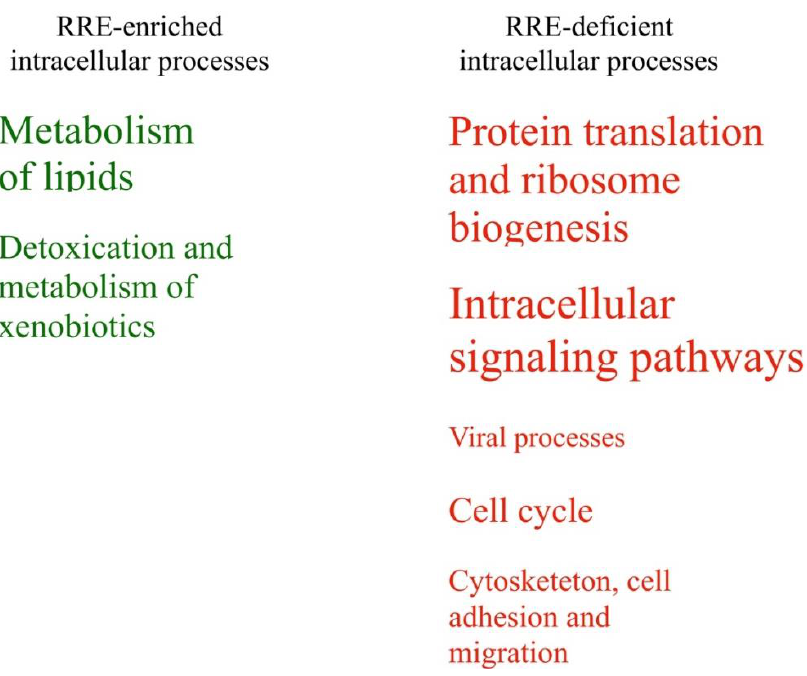
Table 5. RRE-enriched and deficient intracellular processes according to Gene Ontology (GO) and molecular pathway analysis ( evolutionary young REs).